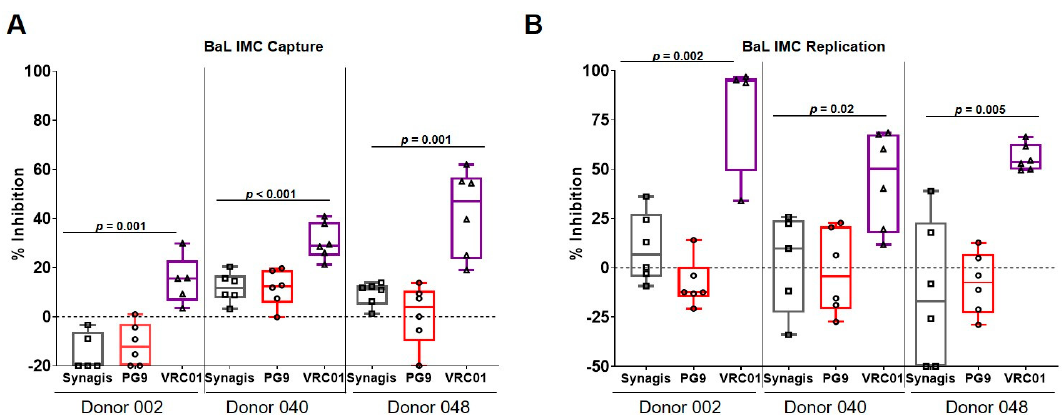
Figure 3. bNAbs inhibited virus capture and replication of BaL IMC. ( A ) Unlike its primary virus counterpart, VRC01 significantly ( p = 0.001) inhibited the capture of BaL IMC in the three donor PBMCs examined, albeit to varying degrees compared to the negative control monoclonal antibody, Synagis. ( B ) VRC01 inhibited BaL IMC replication in the three different donor PBMCs. However, no inhibition was observed with PG9. The data are shown as box-whisker plots (the box extends from the 25th to 75th percentiles; min to max showing all points). The data shown are from at least 2 independent experiments performed in triplicate.